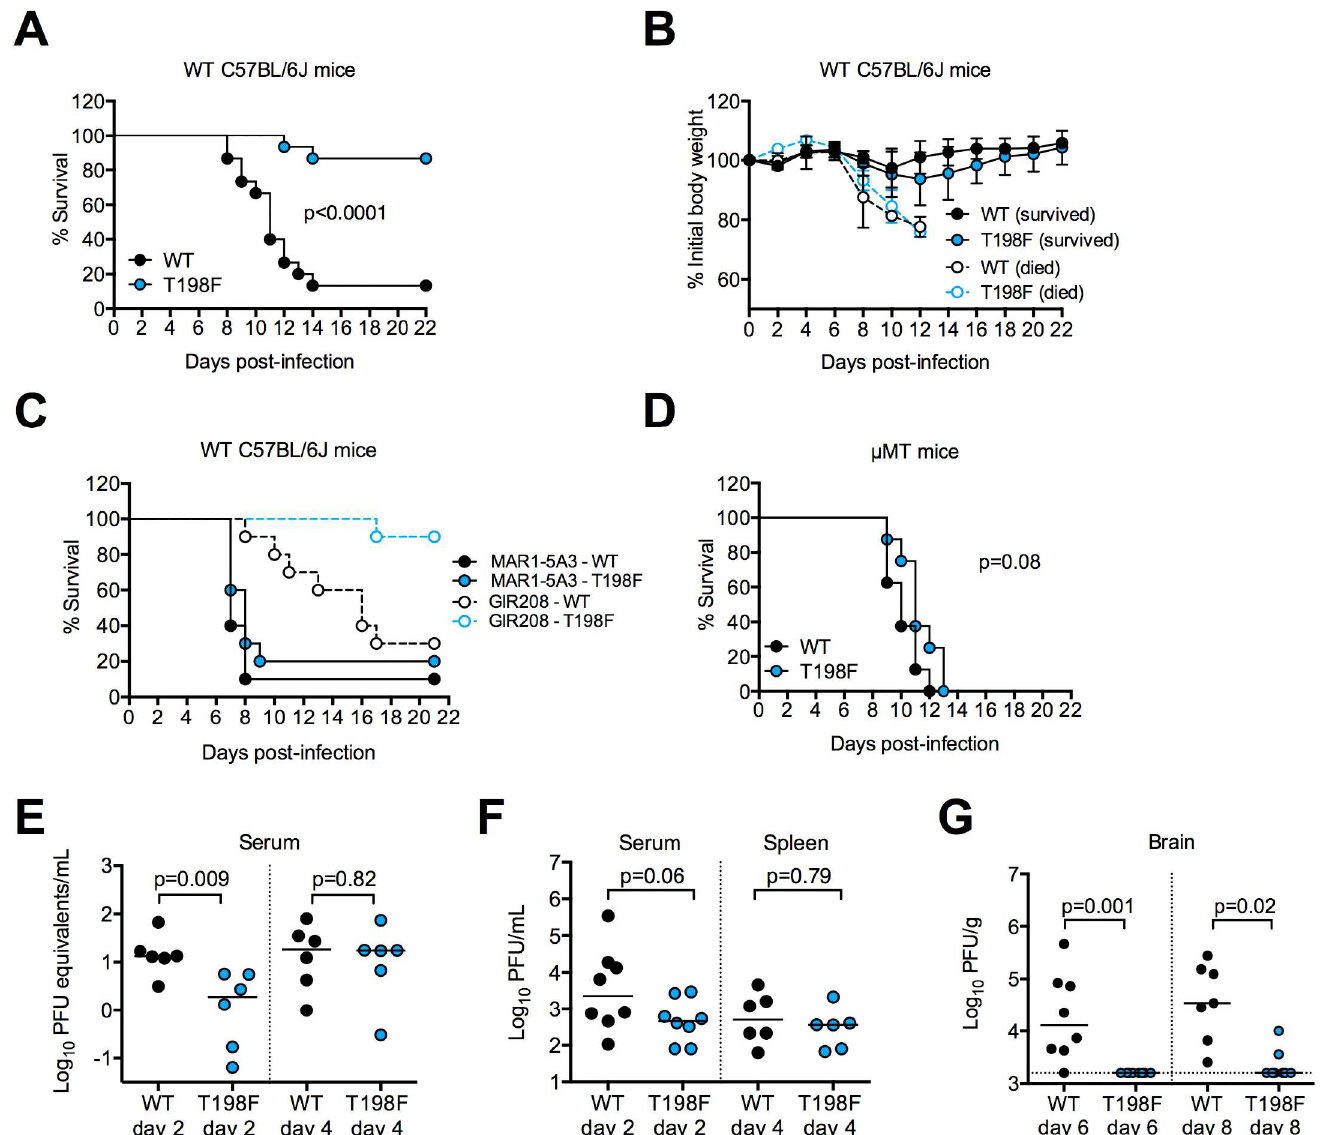
Fig 8. In vivo effectsof WNV E T198F. Five-weekold WT C57BL/6Jmice were inoculatedsubcutaneously with 10 2 FFU of WT (n = 15) or T198F (n = 15) WNV and monitoredfor (A) survival and (B) weight loss. Data are pooledfrom three independent experiments. Error bars in (B) represent the standarddeviation. (C) Nine- to ten-weekold WT C57BL/6Jmice were injectedvia an intraperitoneal route with 0.5 mg each of blockingantibodyagainst mouse IFN- α / β receptor(MAR1-5A3,n = 10) or an isotype control antibodyagainst humanIFN- γ receptor 1 (GIR-208, n = 10) one day prior to subcutaneous inoculationwith 10 2 FFU of WT or T198F WNV. Mice were monitored for survival up to 21 days post-infection. Data are pooledfrom two independent experiments. (D) Eight-week old μ MT mice were inoculated subcutaneously with 10 2 FFU of WT (n = 8) or T198F (n = 8) WNV and monitored for survival. Data are pooledfrom two independentexperiments. (E) Five-weekold WT C57BL/6Jmice were infected with WT (n = 6) or T198F WNV (n = 6) as in (A) . Serum samples were collectedon days 2 and 4 post-infection and viral burdenwas quantifiedby qRT-PCR. Horizontal lines across data points indicatethe medianviral burden. (F) Determination of infectiousvirus titer in the serum and spleen of five-weekold WT C57BL/ 6J mice infected with WT (n = 8) or T198F (n = 8) virus at day 4 post-infection by plaqueassay on Vero or BHK21 cells, respectively. Horizontallines across data points indicatethe median viral titer. (G) Five-week old WT C57BL/6Jmice were infected with WT (n = 8) or T198F WNV (n = 8) as in (A) . Infectioustiter in the brain at 6 and 8 days post-infection was determinedby plaqueassay on BHK21 cells. Horizontallines across data points indicate the median viral titer. Data in (E-G) were pooledfrom two independentexperiments. The p-valuesshown in (A) and (D) were obtainedfrom a log-rank test; those in (E-G) were obtained by a Mann-Whitney